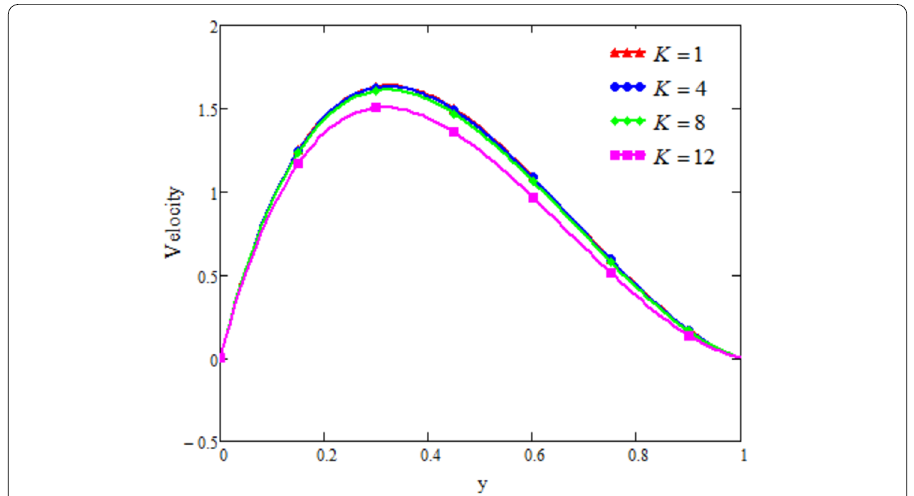
Figure 8 Velocity curves along K variation and α = 0.5, P r = 1.5, G r = 5.5, H a = 0.3, λ = 0.6, λ 1 = 1.9, t = 5